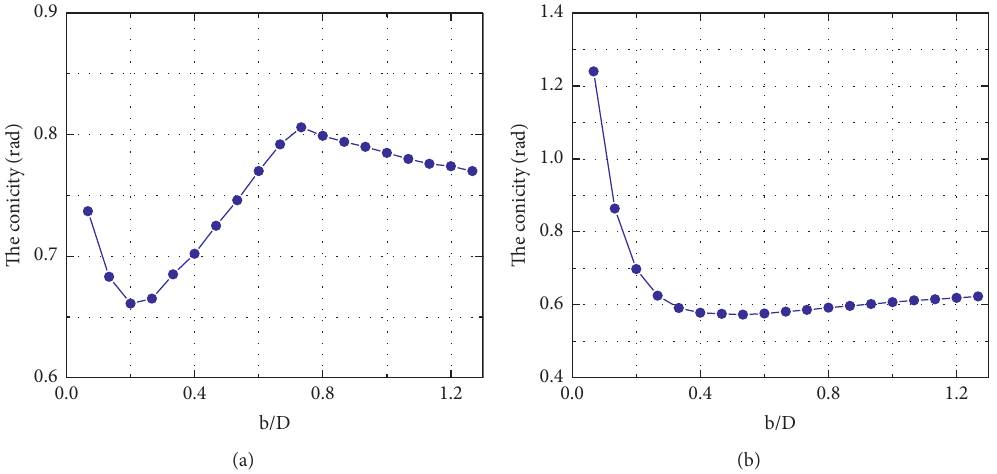
Figure 9: The conicities when d / D is constant. (a) d / D is 0.267 and (b) d / D is 0.667.